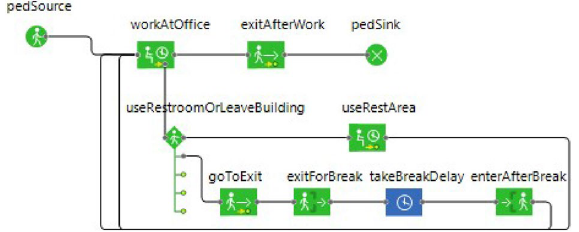
Figure 2. State machine driving agent behavior within the simulated environment of the spatial agent-based model, implemented using AnyLogic’s Pedestrian library.